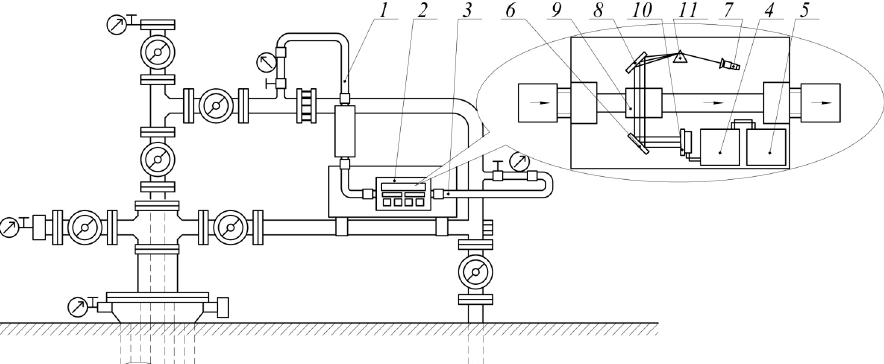
Figure 10. Stationary wellhead device for measuring optical oil properties. 1,3—pressure hoses; 2—measurement photometric unit; 4—analog and digital converter (ADC); 5—electronic data storage and transmission unit; 6—thermosetting unit; 7—source of light emission; 8—monochromator; 9—sample holder; 10—photometry sensor;